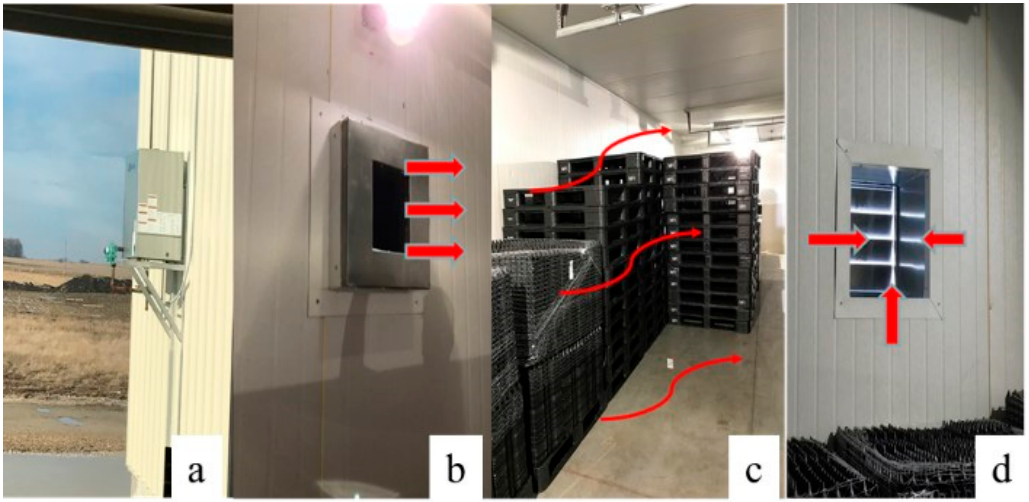
Figure 1. Heat treatment room (room dimension is 11.6 L × 3.9 W × 3 H m; ( a )—heater, ( b )—air outlet of heater, ( c )—stacked pallets/flats, ( d )—air outlet of the room) tested by Chai et al. [60] on a commercial poultry farm.